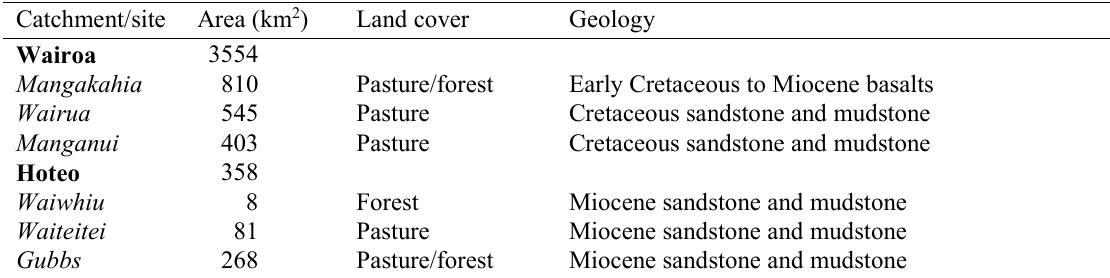
Table 1 Wairoa River and Hoteo River monitoring site catchment